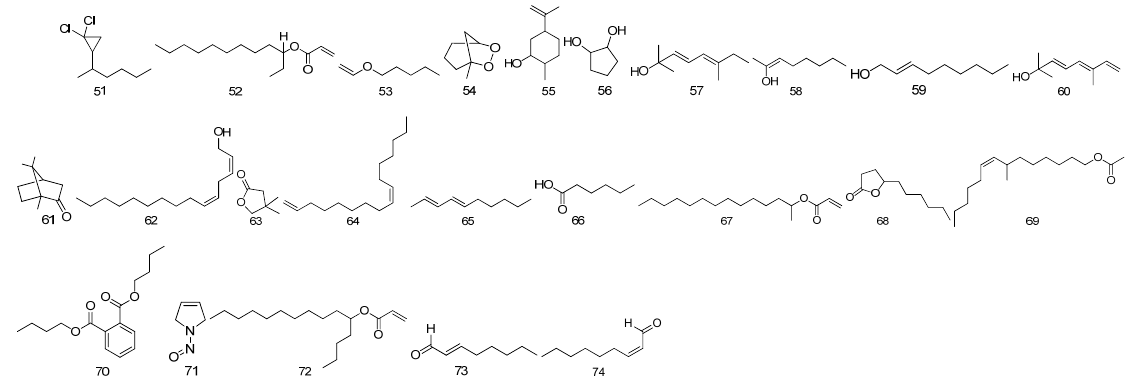
Figure 6. The chemical structures of volatile oils identified from Fructus Malvae .